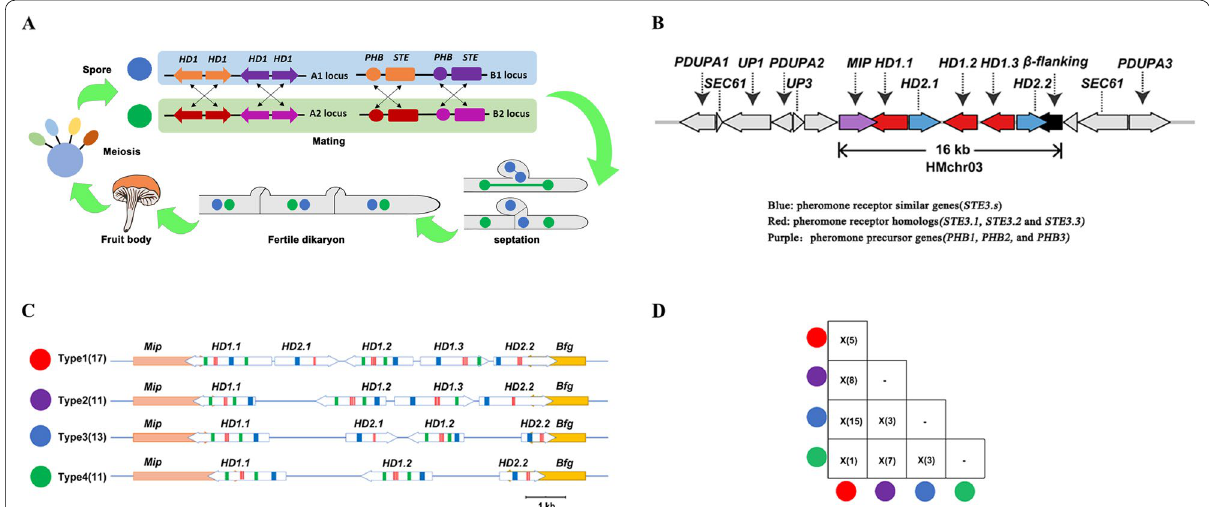
Fig. 1 The structures and types of mating A loci in H. marmoreus . A The life cycle model and tetrapolar mating system of H. marmoreus . HD : Homeodomains; PHB: pheromone precursor genes; STE: pheromone receptor homologs. The direction of the arrow represents the direction of the gene. B The mating HD loci structures. The gene names shown above each arrow. C The type of mating A factor. The blue box represents Homeodomains ( HD ); the green box represents Dimerization motif (Di); the red box represents nuclear localization signals (NLS). The direction of the arrow represents the direction of the gene. D The number of the heterokaryon strains that contain HD mating-type haplotypes. Based on the re-sequencing of 56 dikaryotic strains, 42 of them have two HD mating-type haplotypes. Eleven strains were Type 1 & Type 2, 15 strains were Type 1 & Type 3, three strains were Type 2 & Type 3, seven strains were Type 2 & Type 4, one strain was Type 1 & Type 4, and five strains were Type 1 & Type 1. Different colors represent different HD mating type